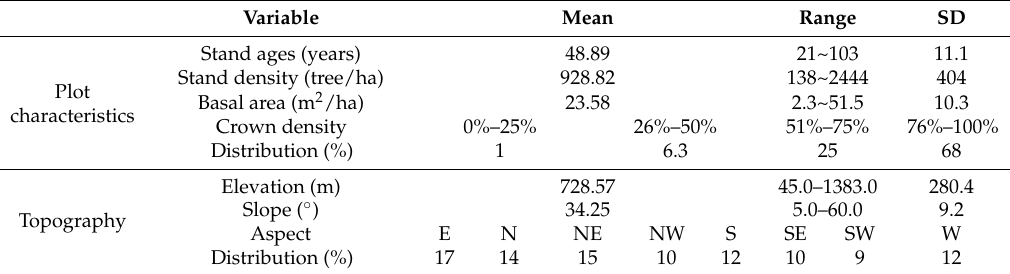
Table 1. Summary of the 134 clusters with 441 subplots of the sixth national forest inventory